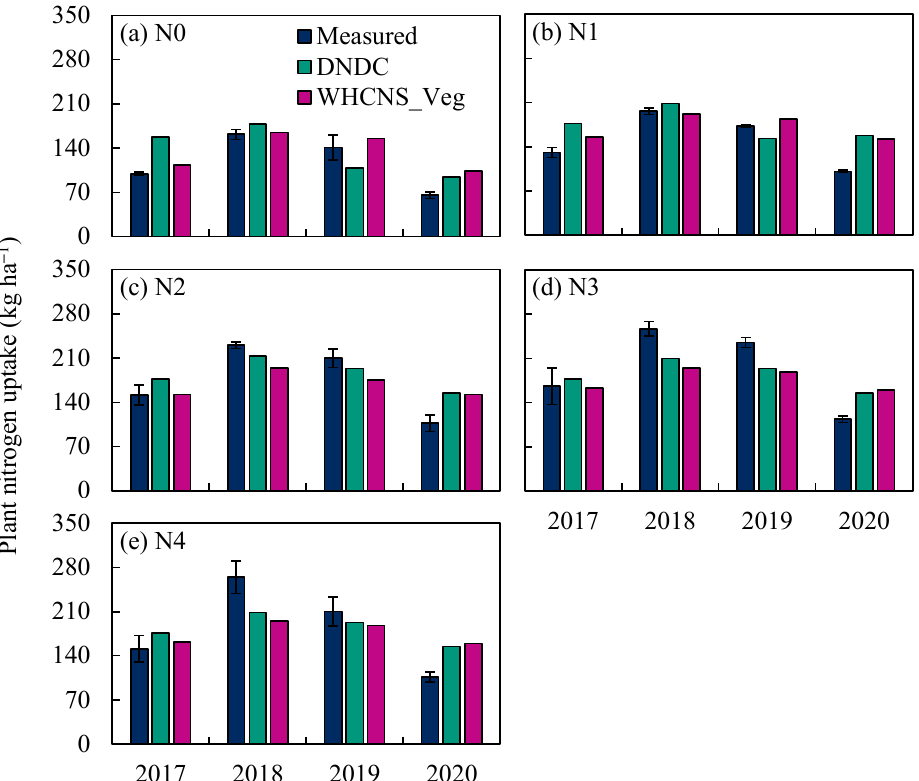
Figure 2. Measured and simulated potato plant N uptake from 2017 to 2020 for different N application treatments using the DNDC and WHCNS_Veg models in Wuchuan, China. ( a ) N0 treatment; ( b ) N1 treatment ( c ) N2 treatment ( d ) N3 treatment ( e ) N4 treatment. Vertical bars are standard deviations ( n = 3).